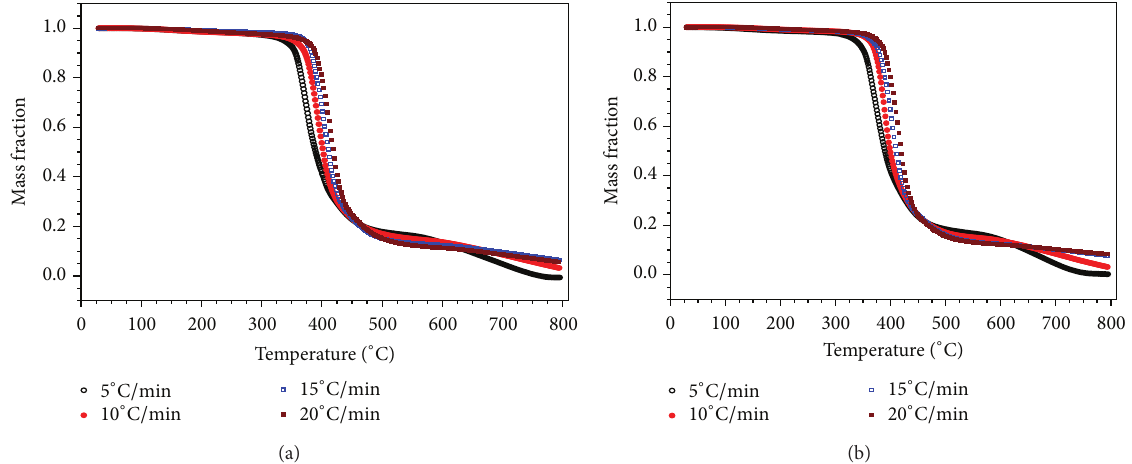
Figure 14: TGA thermograms for (a) neat epoxy and (b) 1-wt.% EG epoxy composites for different heating rates.